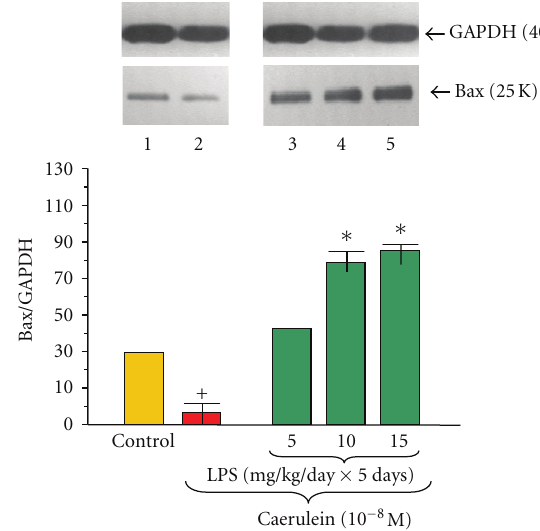
Figure 6: Western blot analysis of Bax protein level in the adult rat pancreatic acinar cells under basal conditions (lane 1), stimulated in vitro by caerulein at the dose of 10 − 8 M (lane 2), treated in the infant animals by lipopolysaccharide ( Escherichia coli ) at the doses of 5mg/kg/day × 5 days + caerulein 10 − 8 M (lane 3), 10mg/kg/day × 5 days + caerulein 10 − 8 M (lane 4), and 15 mg/kg/day × 5 days + caerulein 10 − 8 M (lane 5) after 5 hours of incubation. Cross indicates significant ( P < 0 . 05) change, as compared to the control group. Asterisk indicates significant ( P < 0 . 05) change, as compared to the value obtained from the rats treated by increasing doses of LPS (10 or 15 mg/kg/day × 5 days) in combination with caerulein (10 − 8 M), as compared to the caerulein (10 − 8 M) alone stimulation. The blots were stripped and probed with GAPDH to document equal protein loading. All presented results were obtained in 4 consecutive experiments and are representative of the observed phenomenon.